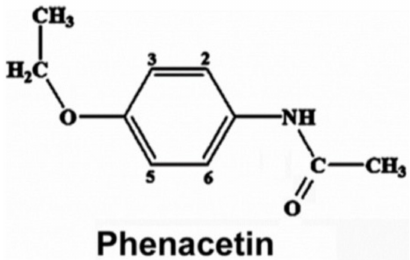
Figure 1. Structure of phenacetin with protons numbered as referenced in the text. Proton abstraction occurs at the –OCH 2 – group, which is the oxidation site.